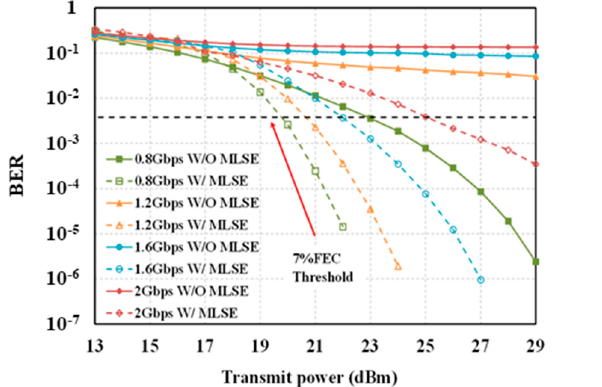
Figure 13. Required transmit power versus transmission distance with OOK modulation in harbor water with 30° FOV. From Figure 13, it is observed that when the transmission distance is short, the MLSE can effectively reduce the power budget. For example, the power budget is reduced by 4 dB after using MLSE for a transmission rate and distance of 0.8 Gb/s and 10 m, respec- tively. When the signal could not be transmitted due to temporal dispersion, we are able to achieve a 14-meter transmission by utilizing MLSE. Therefore, MLSE is a feasible algo- rithm for realizing transmission with a large bandwidth and to effectively reduce the power budget in turbid harbor water. 6. Conclusions For UWOC systems, there still exist bandwidth limitations, with a lack of studies to investigate its influence on system’s performance and effective compensation methods for 10